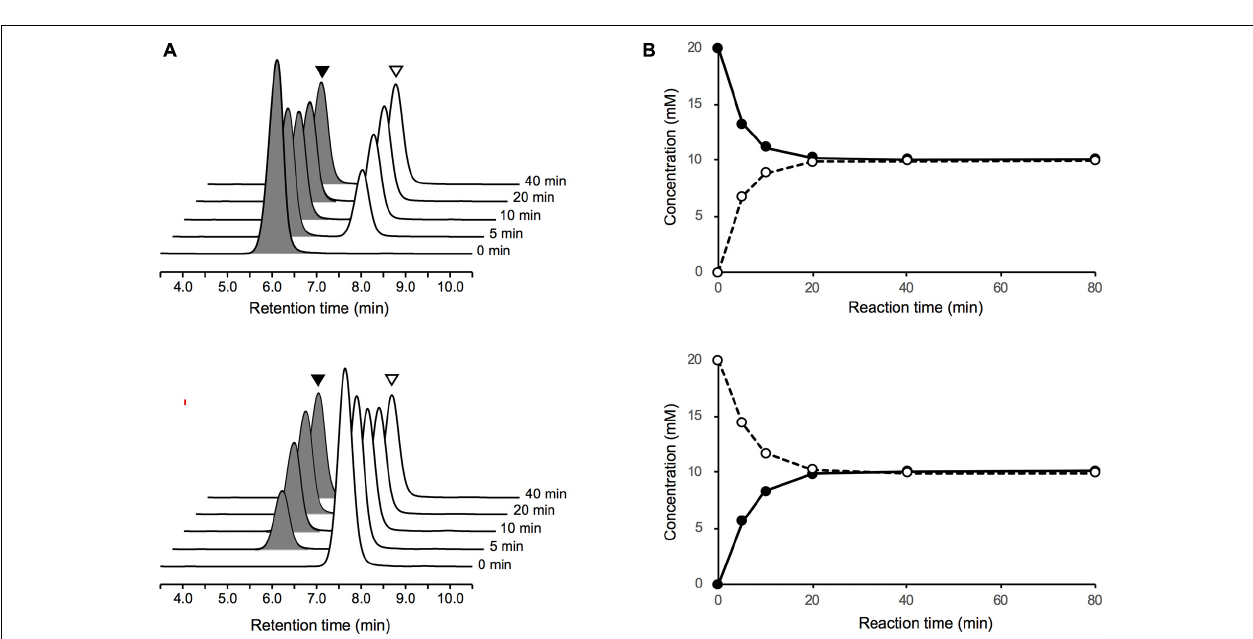
FIGURE 3 | LC-MS analysis of Dab racemase reactions catalyzed by PddB. (A) Stereoinversions from 20 mM of L -Dab (black arrowheads) and from D -Dab (white arrowheads) monitored at 340 nm are shown the in upper and lower panels, respectively. All peaks presented exhibited 707.3 m/z as (M + H) + , which corresponded to Dab doubly labeled with FDLA, and no singly labeled Dab was detected. (B) Transition of the stereoinversion reactions from 20 mM of L -Dab (closed circle with a solid line) and from D -Dab (open circle with a dotted line) calculated based on the LC chromatograms are shown in the upper and lower panels, respectively.